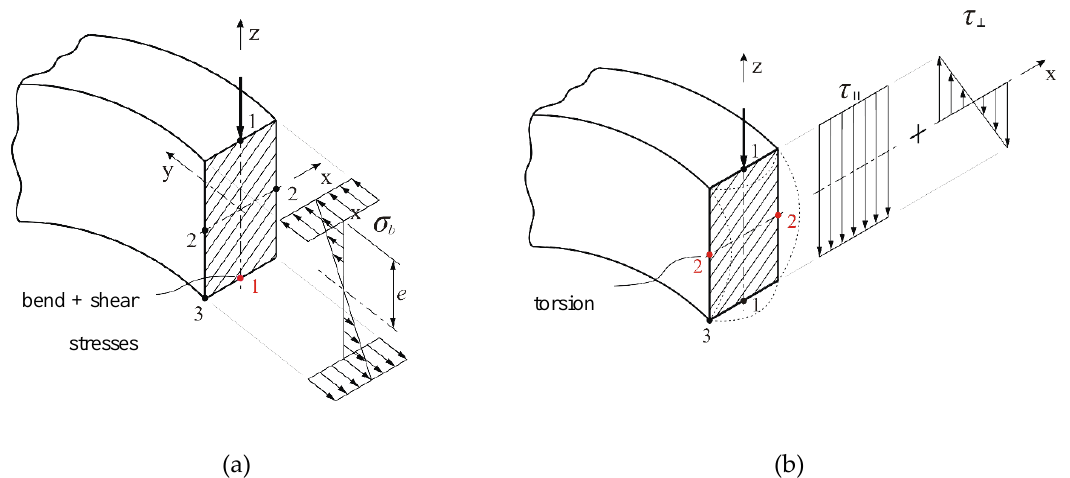
Figure 2. ( a ) Schematic view of the distribution of the bending stresses to the critical cross-section A and ( b ) schematic view of the distribution of both tangential and torsional stresses on the critical cross-section A [4–8].